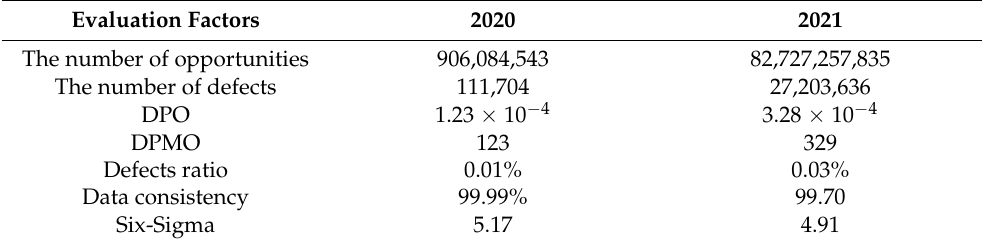
Table 4. Defects ratio and Six-Sigma value in data